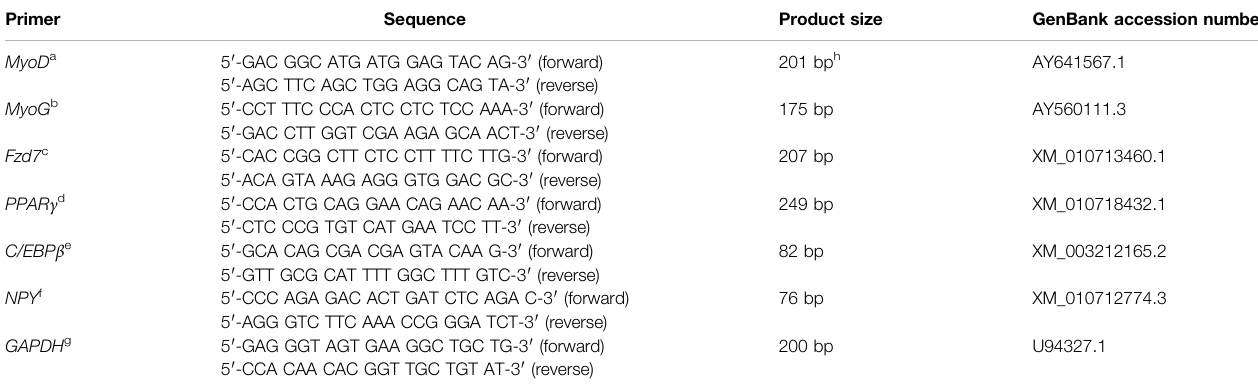
TABLE 1 | Primer sequences for real-time quantitative polymerase chain